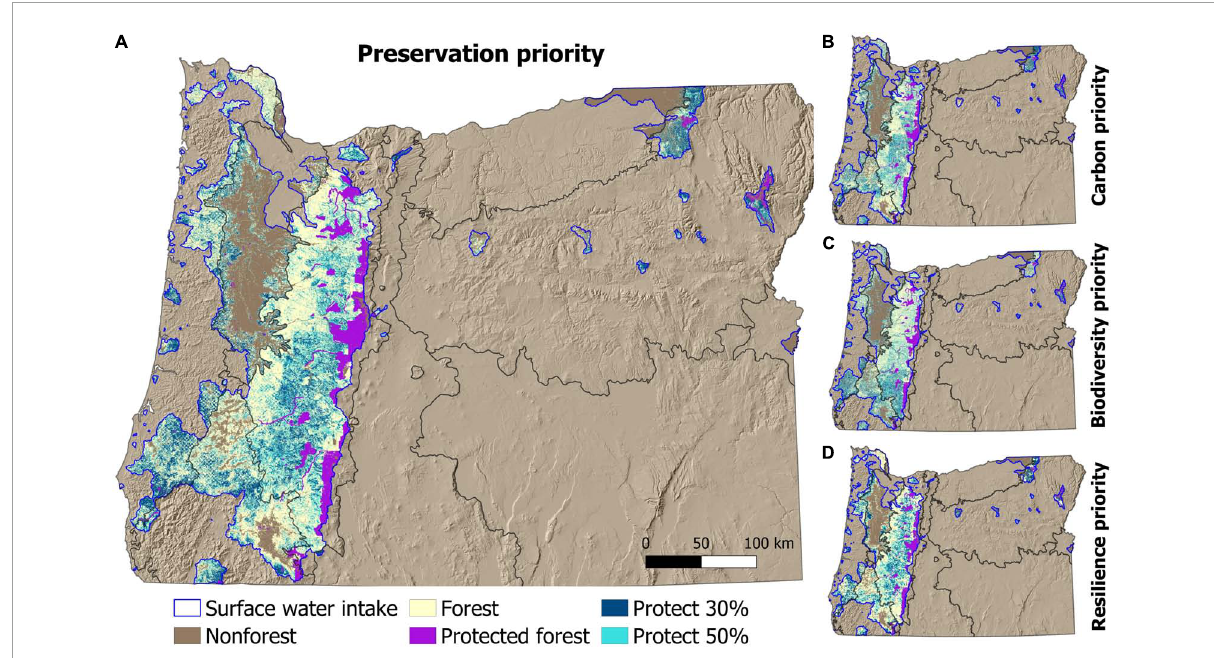
FIGURE8 Current and potential protection of surface drinking water source areas in forestlands across Oregon. Potential protection is shown for the (A) forest preservation priority targets, as well as for (B) carbon, (C) biodiversity, and (D) climate resilience priority targets. Surface drinking water source area data were from the Oregon Department of Environmental Quality (Oregon Department of Environmental Quality [DEQ],